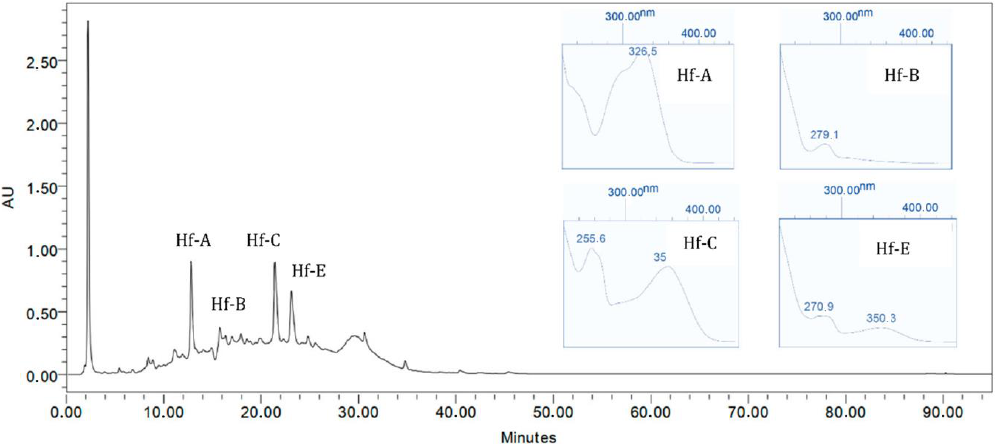
Figure 5. Hypericum foliosum hydroethanolic extract maxplot ( λ = 190 – 450 nm) chromatogram.